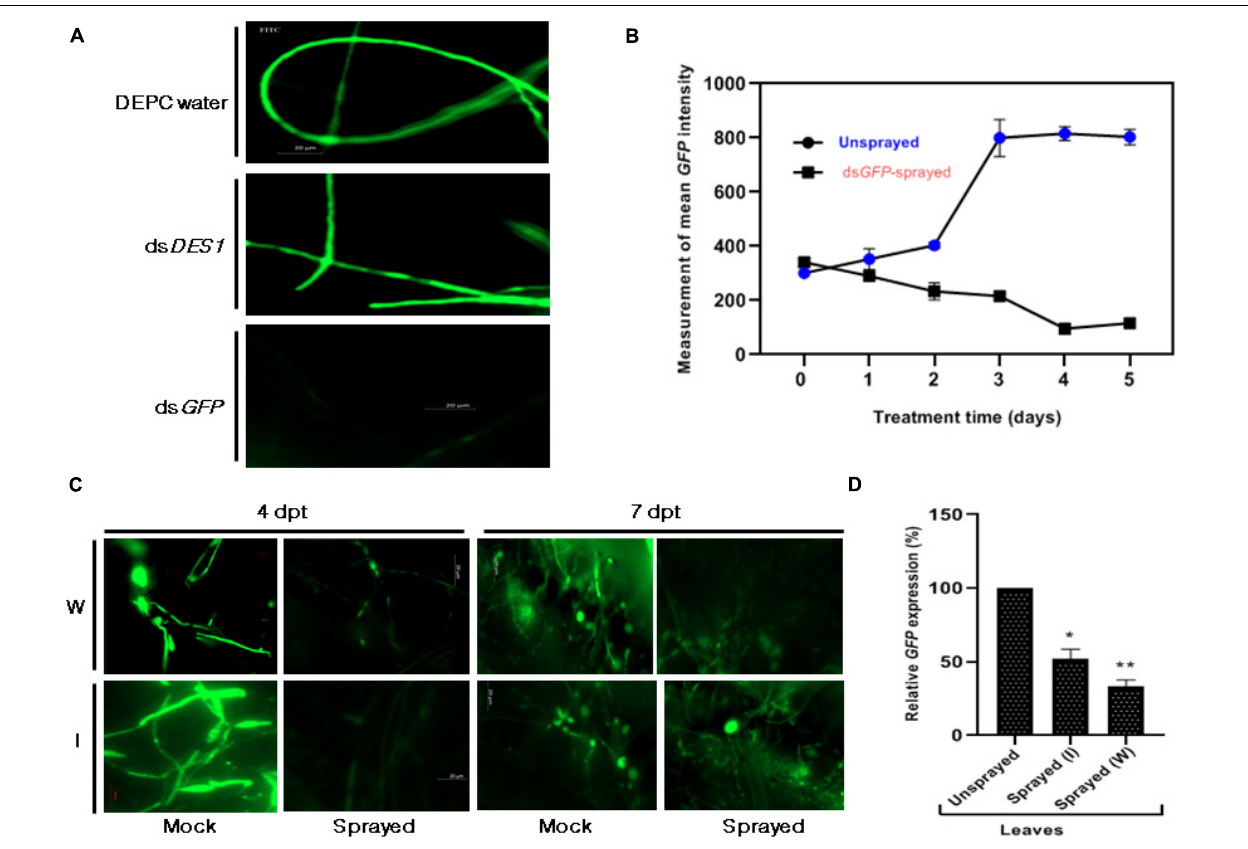
FIGURE 2 | Effect of ds GFP on M. oryzae GFP. (A) Microscopic assessment of GFP intensity 3 dpt, among axenic cultures of M. oryzae GFP fed with and without ds GFP . While the culture that was not fed with any dsRNA (DEPC water- treated) was kept as the negative control, the culture that was fed with ds DES1 (non-specific for GFP ) served as the positive control. (B) Time-dependent fluorescence trend of M. oryzaeGFP grown on 300 nM ds GFP -sprayed leaves with respect to the unsprayed set, across 0–5 days. (C) Fluorescence of M. oryzaeGFP on wounded (W) and intact (I) rice leaves sprayed with ds GFP, 24 h prior to infection. GFP fluorescence was observed under an FITC filter of AxioCam mRm 0 [4 h post treatment (hpt)], 4, and 7 dpt, and fluorescence emitted by M. oryzaeGFP on Tris EDTA (TE)-sprayed leaves were kept as mock. TE was sprayed 24 h prior to infection, as replacement for ds GFP . Comparisons were made between the sets, at similar time points, with observations made from at least 10 leaves for each set. The experiment was repeated thrice, and the results were compared independently. (D) Relative abundance of GFP transcripts in dsRNA-sprayed wounded and intact leaves, with respect to TE-sprayed leaves, at 4 dpt. OsACTIN was used as internal control for normalization. The experiments were repeated thrice, each time with three biological replicates. Error bars represent standard deviation ( n = 3), where * and ** denote statistical significance at the P ≤ 0.05 and P ≤ 0.01 levels, respectively.